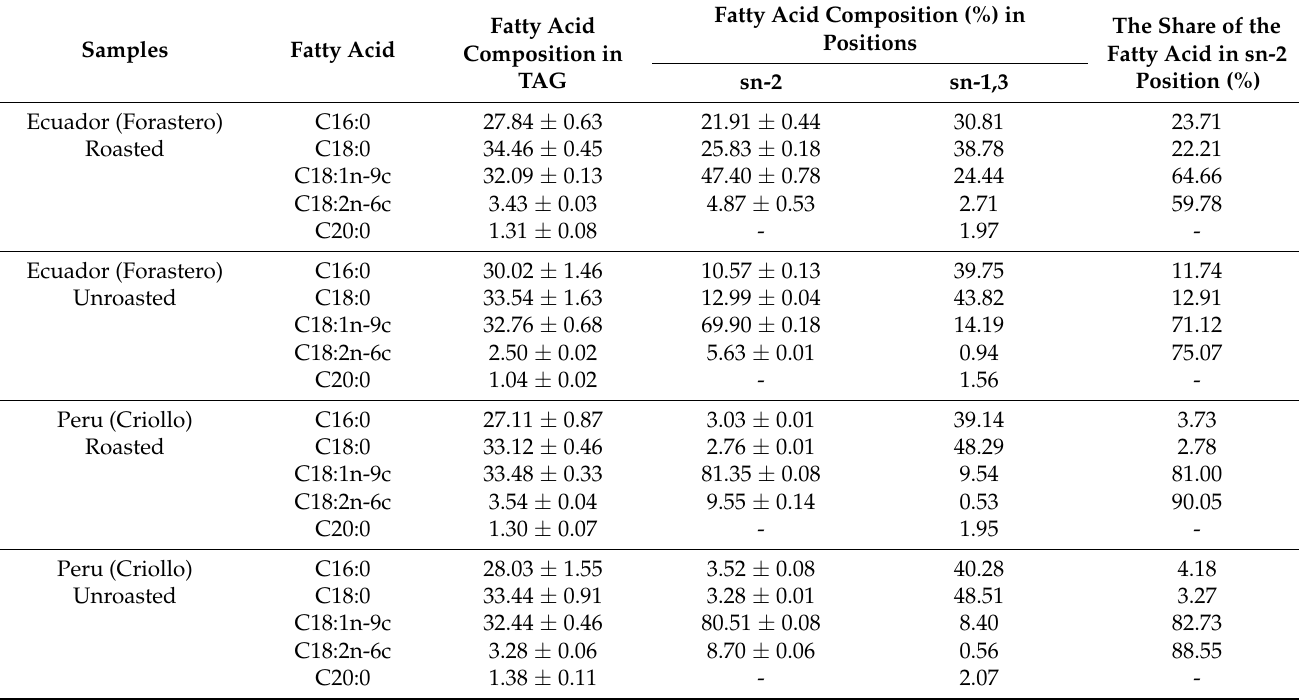
Fatty Acid Composition (%) in Fatty Acid Positions Composition in TAG